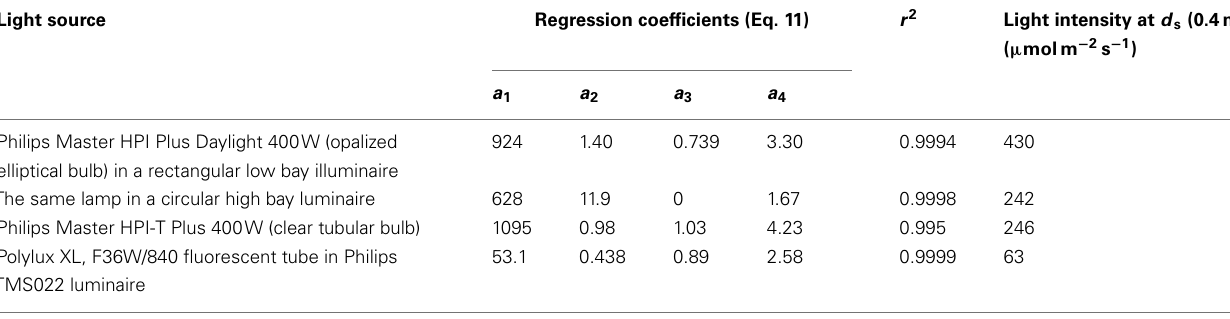
Table 2 | Distance-dependent changes in light intensity for four different plant growth light sources. Light